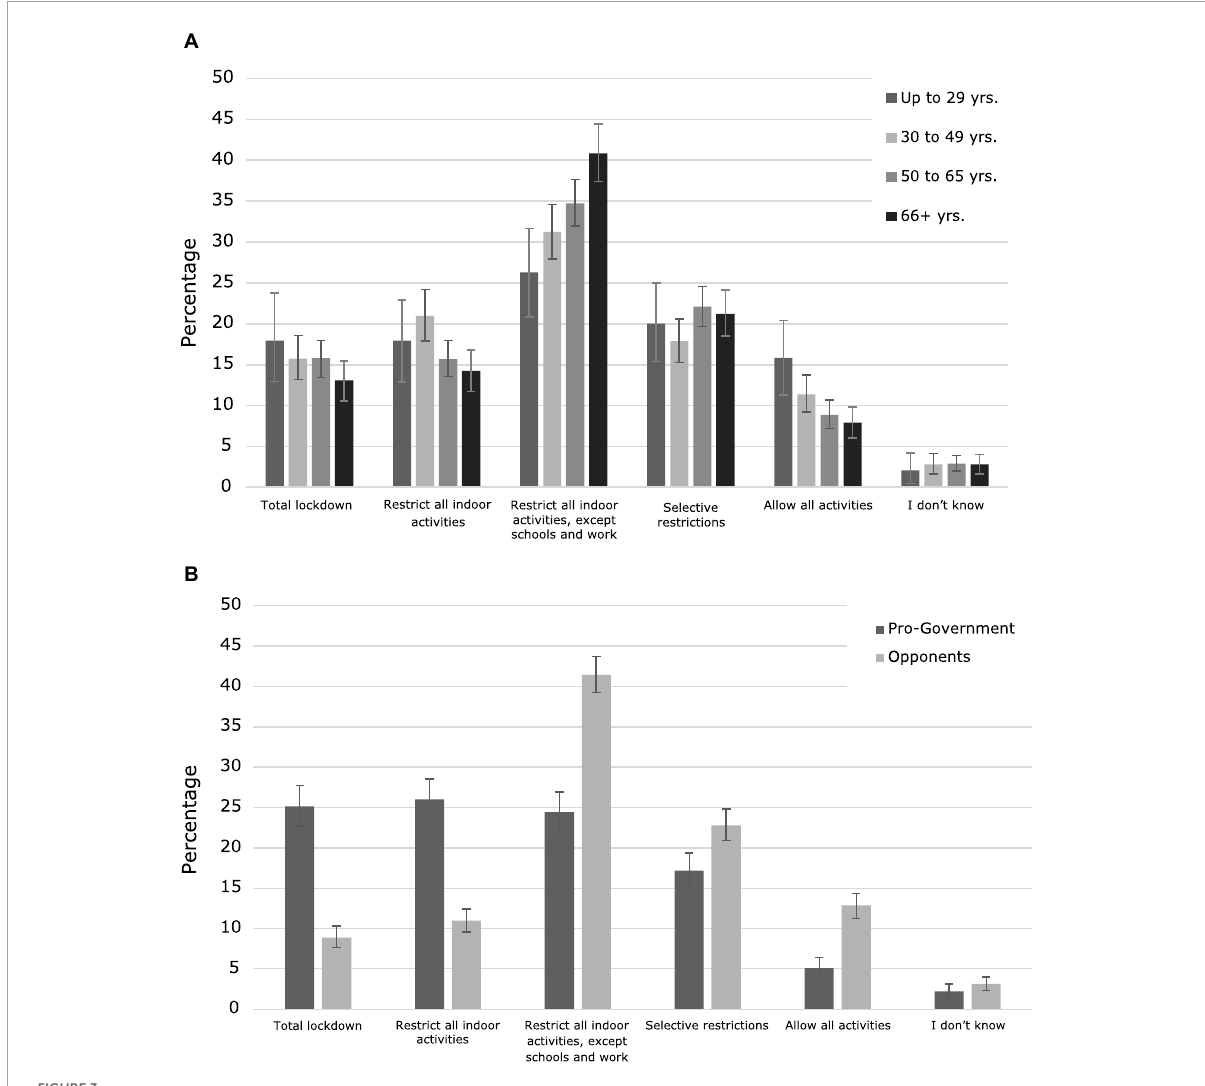
FIGURE3 Support for government restrictive measures. (A) Percentage of participants supporting the different levels of restriction according to age groups. (B) Percentage of participants supporting the different levels of restriction according to political orientation. Error bars represent bootstrapped 95% CI.